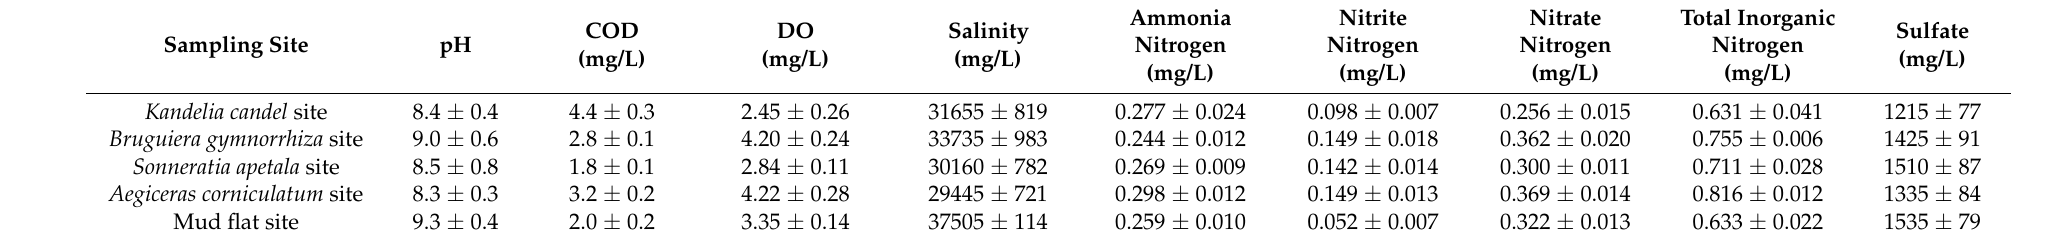
Table 2. Physical and chemical parameters of the seawater